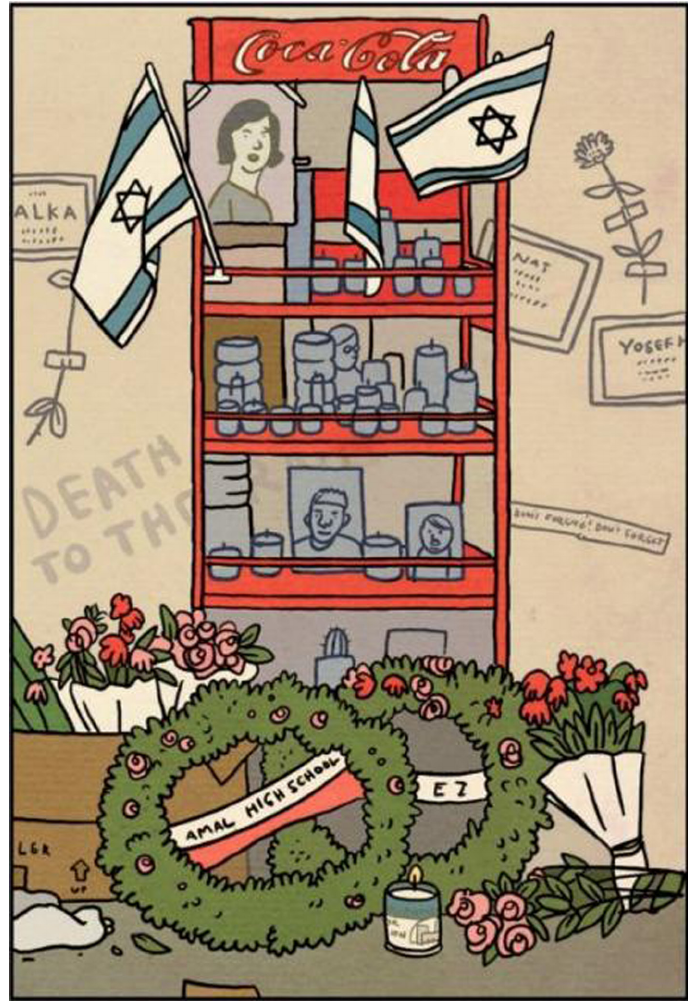
Figure 7: A Depoliticized Memorial to Suicide Bombing Victims Acts to Regulate Emotional Responses in Exit Wounds by Rutu Modan, 2007: 64. © 2007 Drawn & Quarterly – Rutu